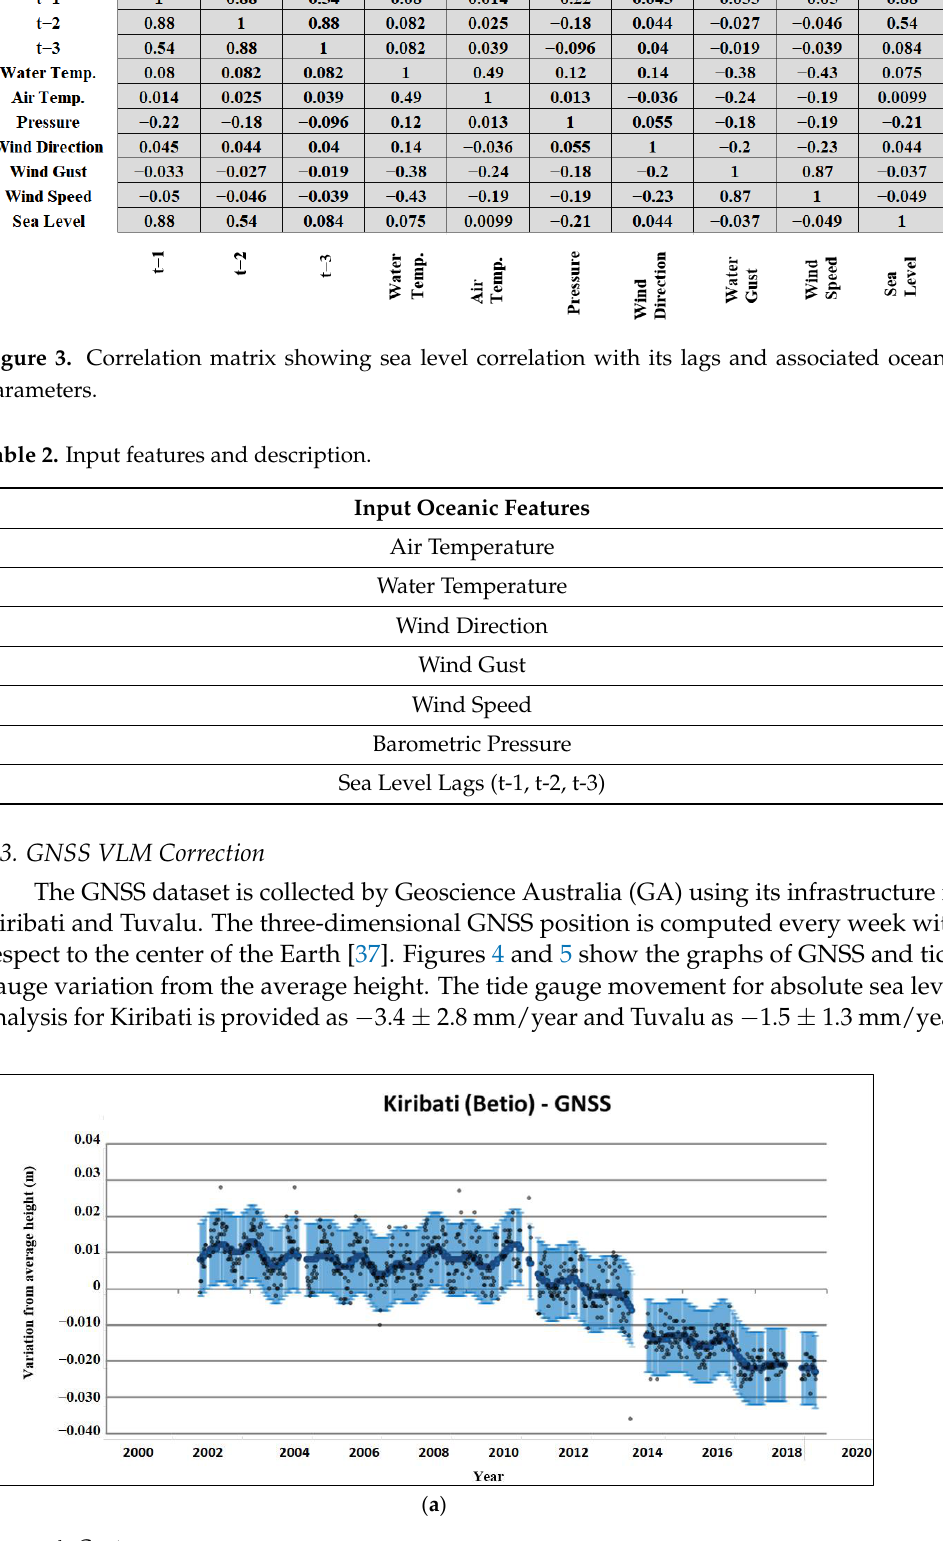
( b ) Figure 4. ( a ) The height changes of the GNSS site from the Betio tide gauge. The dots show the GNSS site heights recorded on a weekly basis. The error bars are shown with the light blue line given at a 95% confidence interval. ( b ) The absolute height changes of the tide gauge with the error bars at a 95% confidence interval. Source: Pacific Sea Level Monitoring Project (bom.gov.au accessed on 10 February 2022).